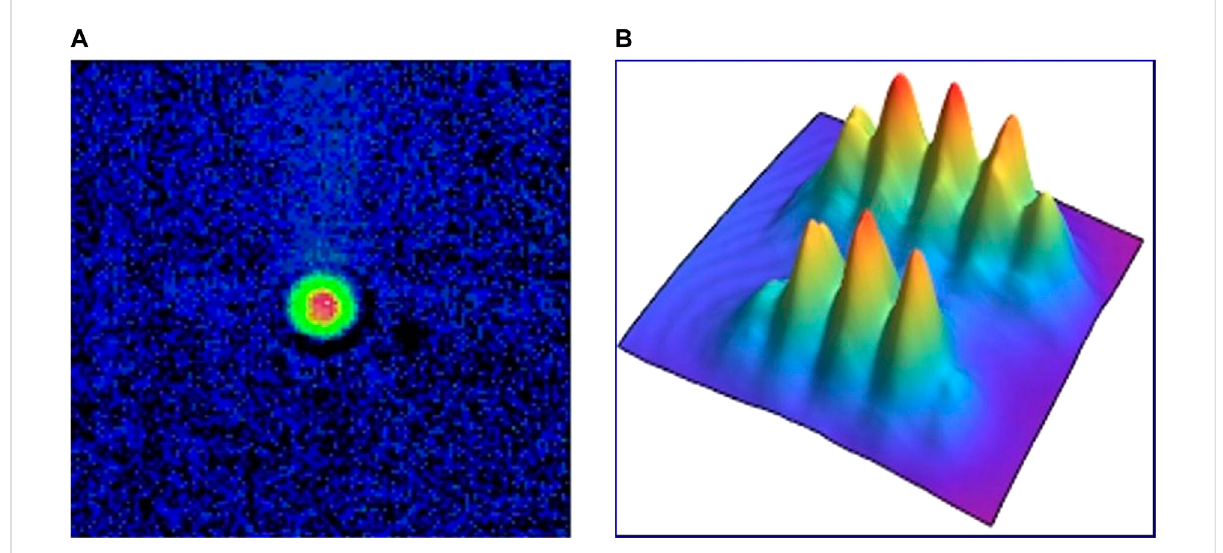
FIGURE 3 (A) 87 Rbatomsintheopticaldipoletrap.Thereare4×10 5 atomsat500 nKaftertheevaporativecooling. (B) Dual-speciesinterferencefringefor T = 203 m. The upper ground state for 85 Rb atoms with the resolution of 1.5 × 10 – 9 g and the lower ground state for 87 Rb atoms of 1.0 × 10 – 9 g.